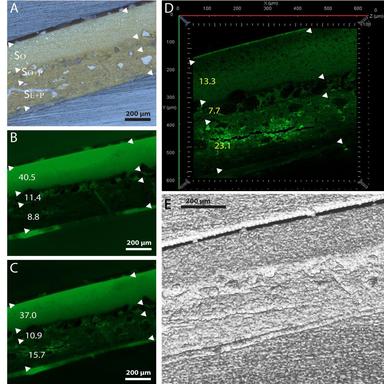
Cross section images of the yellowish brown coloured micro (model) sample, containing the pigment yellow ochre, photographed prior to antibody hybridization using the reflected-light brightfield observation (texp 2.9 ms, frame A) and the widefield fluorescence observation (texp 1000 ms, frame B) modes. After antibody hybridization, the sample was again captured in the widefield fluorescence observation mode under the same illumination conditions (frame C) and was laser scanned using confocal fluorescence mi